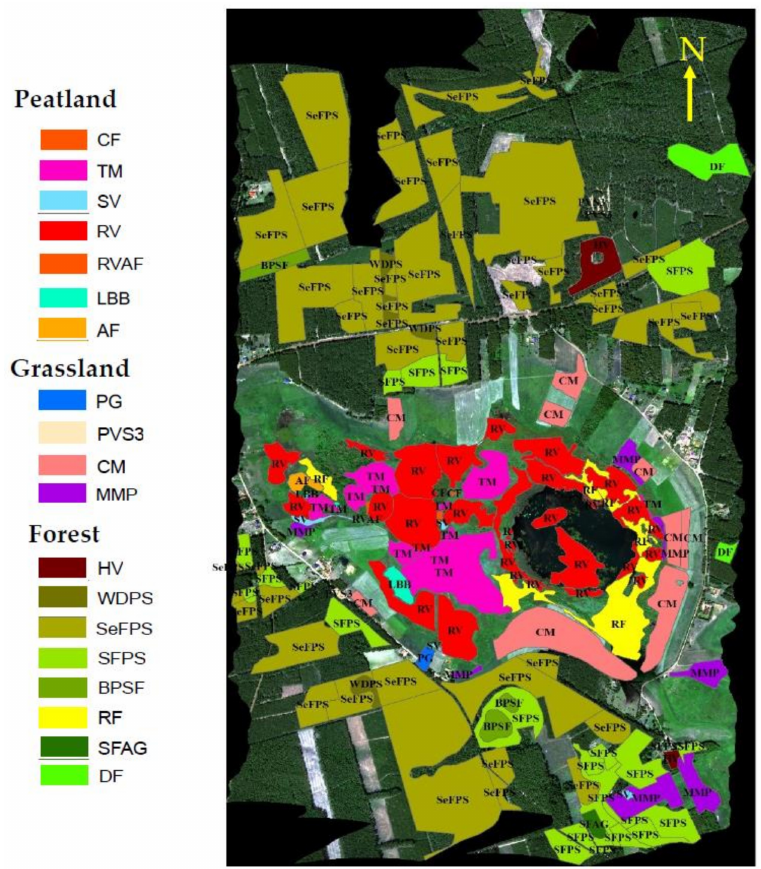
Figure 2. Location and boundaries of the 158 ROIs identified in the HyPlant RGB image and categorized into 19 unique vegetation groups. Adopted after Bandopadhyay et al. [1]. Legend: (i) Forest vegetation groups: Herbaceous vegetation of forest clearings (HV); wooded dunes with Pinus sylvestris L. (WDPS); semi-natural forests with Pinus sylvestris L. (SeFPS); secondary forest communities with Pinus sylvestris L. (SFPS); Betula pendula Roth— secondary forest communities (BPFS); riparian forests (RF); secondary forest communities with Alnus glutinosa (L.) Gaertn. (SFAG); deciduous forest (DF); (ii) Grassland vegetation groups: post-agriculture land (PG); pioneer vegetation of sandy and shallow soils (PVS3); mowed meadows and mesic pastures (CM); meadows and mesic pastures (MMP); (iii) Peat- land vegetation groups: Calcareous fens (CF); transition mires (TM); sedge vegetation (SV); rush vegetation (RV); rush vegetation/alkaline fens (RVAF); low birch bush (LBB); alder forest